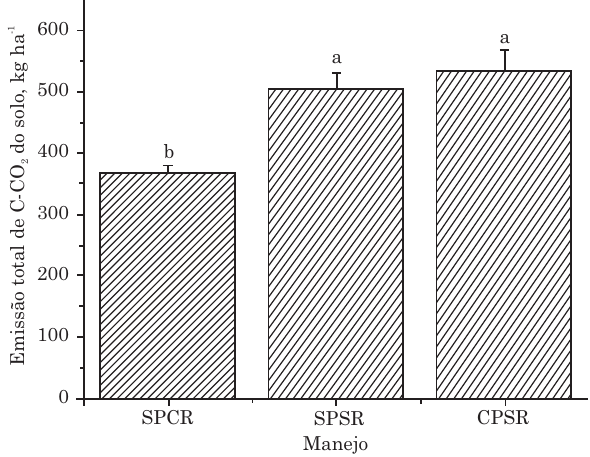
Figura 3. Emissão total de C-CO 2 , com barras de erro- padrão, nos diferentes manejos avaliados em 15 dias de